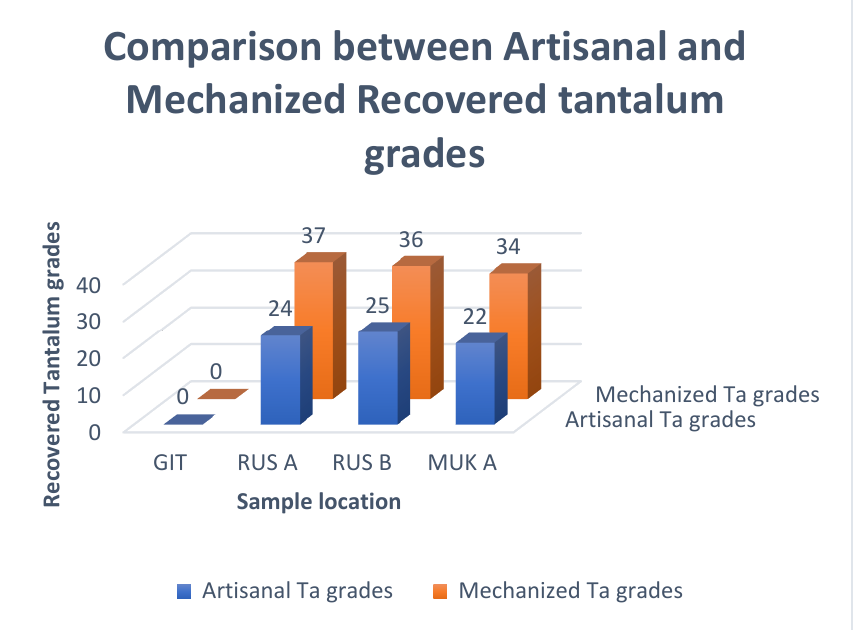
Figure 8. Comparison between tantalum grades from artisanal and mechanized recovery.